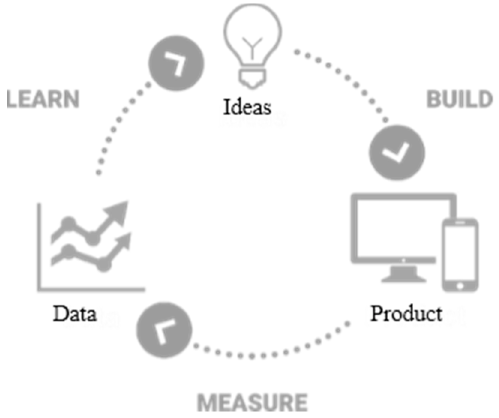
Figure 1. Lean UX learning loop.